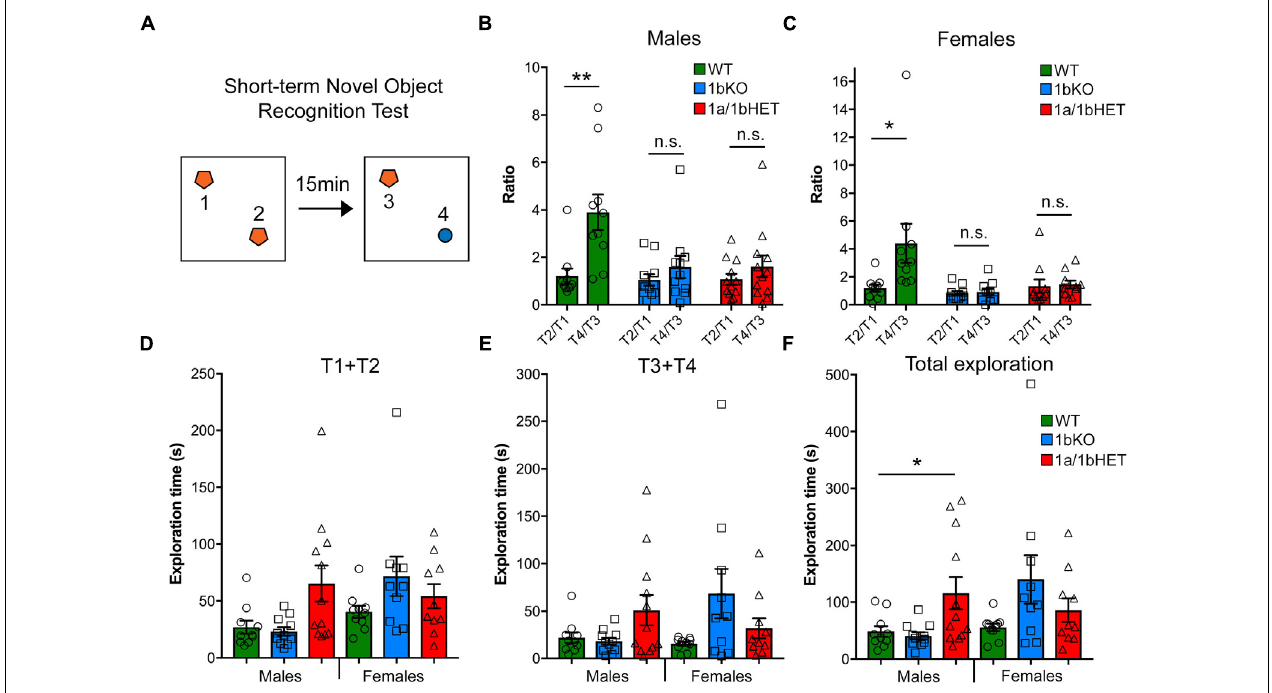
FIGURE 3 | CC2D1A and CC2D1B are both involved in object memory. (A) Schematic design of short-term novel object recognition test (NORT), with a novel object replacing a familiar object after a 15 min interval. (B,C) In contrast to WT, 1bKO, and 1a/1bHET male (B) and female (C) mice showed no preference for the novel object relative to a familiar object. Results expressed as mean ± SEM, ∗∗ p < 0.01 (two-tailed t -test with equal variance). (D–F) Exploration time divided by initial exploration of training objects 1 and 2 (D) , test objects 3 and 4 (E) and total exploration across the two phases of the NORT (F) . 1a-1bHET males show a trend toward increased exploration in each test phase which reaches significance when both phases are combined. Results expressed as mean ± SEM, one-way ANOVA with Dunnett’s multiple comparison test, ∗ p < 0.05, ∗∗ p < 0.01.